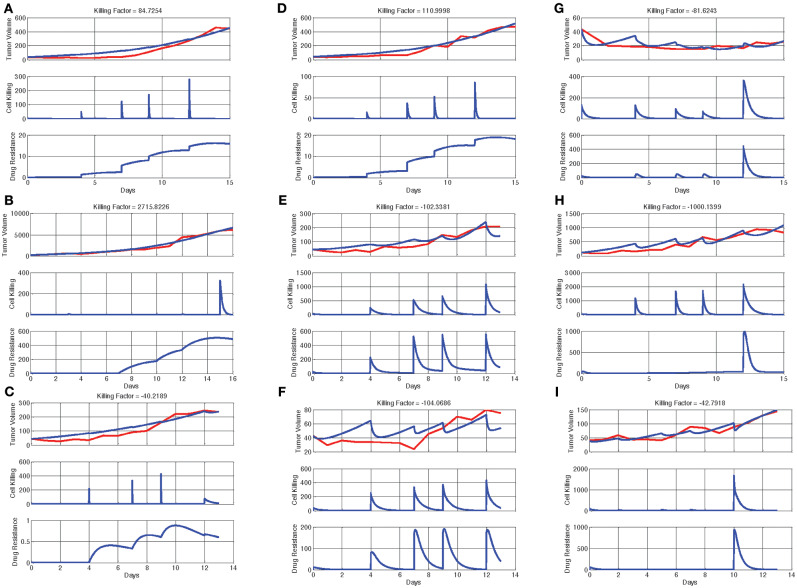
Output of the mathematical model (n(t)) and the measured tumor size, CK(u(t)), and R(u(t)) for four different animal models. Each graph has three parts: tumor volume, cell killing, and drug resistance. In the first part, the blue line shows real rate of tumor growth with DAPT treatment of control group in each mice, and the red line is the growth rate of DAPT treatment in each mice that were calculated with mathematical model. If the red and blue lines are more consistent, it means that the model is more similar to reality and more accurate. The total of these three parts provides killing factor: if the killing factor is negative, the drug was effective, and if the killing factor is positive, the treatment is harmful. (A–D) Animals with a positive killing factor were drug resistant. (E,F) Animals with a negative killing factor. These animals are remediable, and all of the injections were effective. (G–I) Animals with a negative killing factor. All of injections were not effective in these animals.